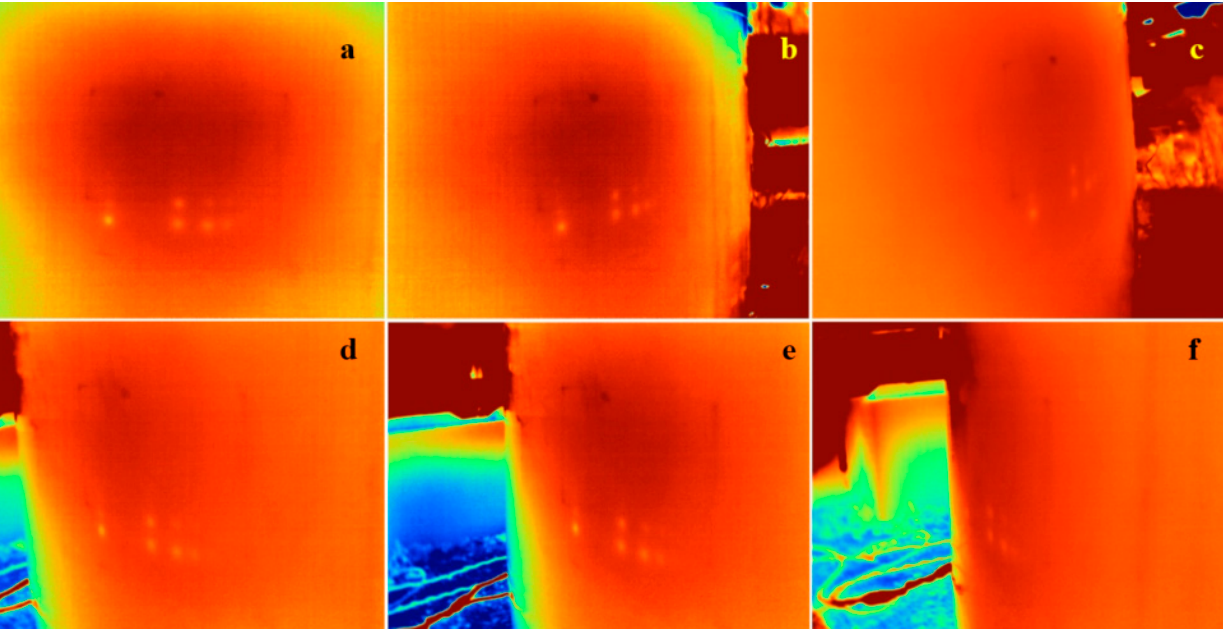
Figure 14. Impact of close heating on the defect detection ( a ) localized and non-uniform heating ( b ) uniform heating.